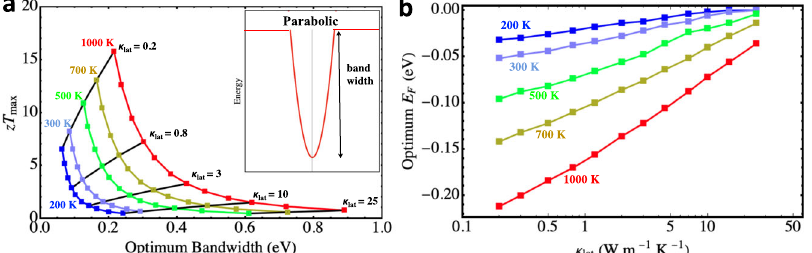
Fig. 4 Optimum bandwidth, Fermi level, and zT . a T - and κ lat -dependent optimum bandwidth and zT under DPS for an isotropic 3D parabolic band of m GaAs = 0.067, and b the optimum Fermi level for each point. The lower the κ lat , the lower the optimum E F and W opt . κ lat is given in W m − 1 K − 1